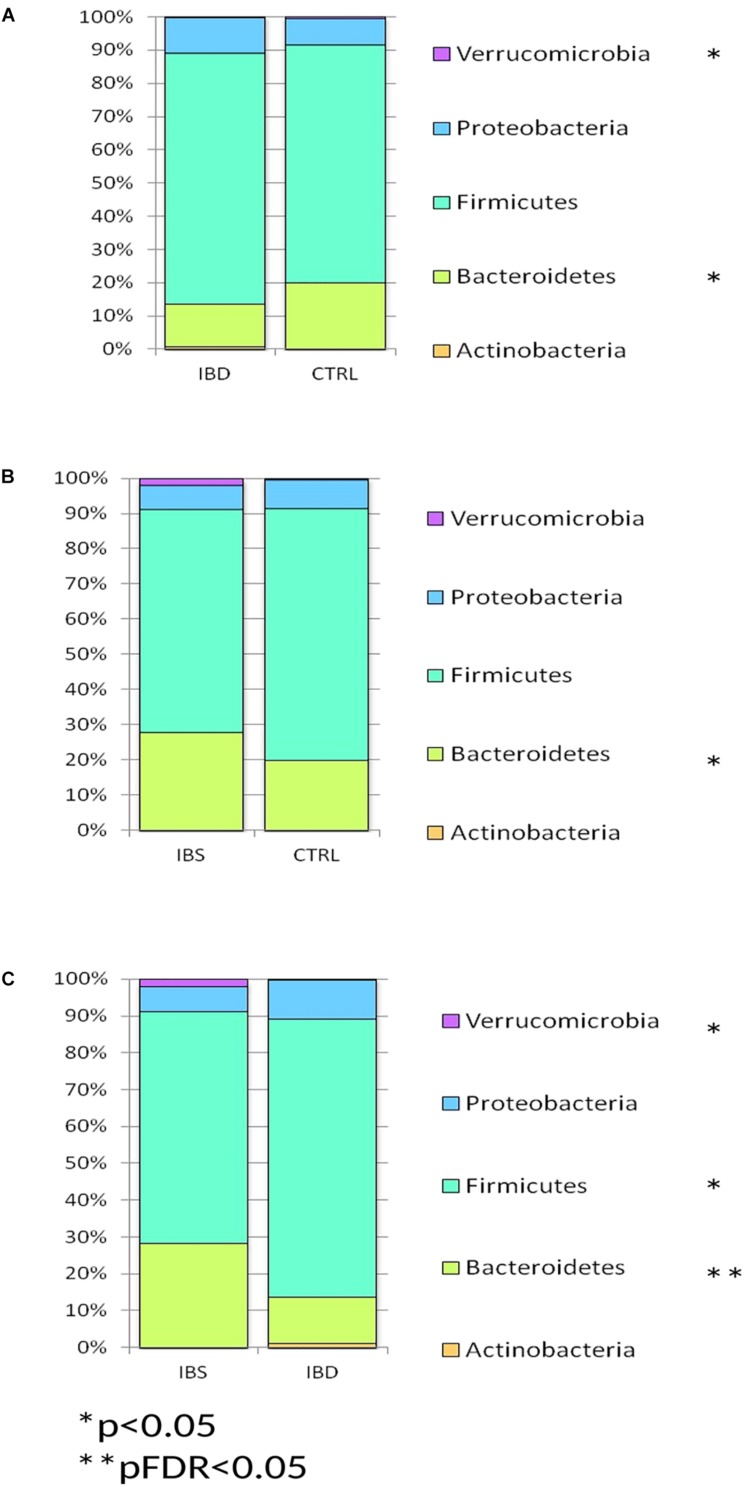
Bar chart reporting Kruskal-Wallis test results on OTUs grouped at taxonomic level of phylum for IBD vs. CTRL (A), IBS vs. CTRL (B), and IBD vs. IBS (C), in fecal samples. Fecal samples have been grouped and averaged in the comparisons IBD vs. CTRL (A), IBS vs. CTRL (B), and IBD vs. IBS (C). Each column in the plot represents a group, and each color in the column represents the percentage of relative abundance for each phyla.